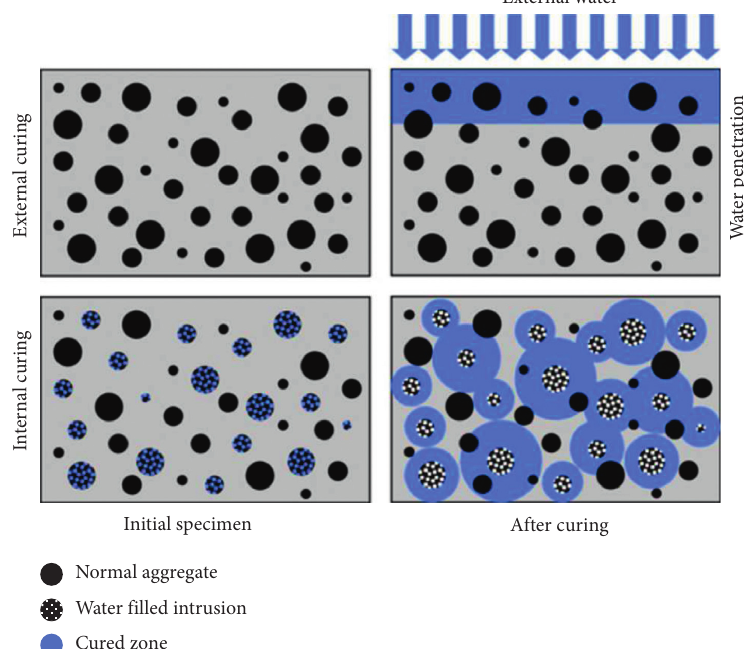
Figure 14: Conceptual illustration of the differences between external and internal curing, reproduced from [30], with permission from Elsevier, 2021.